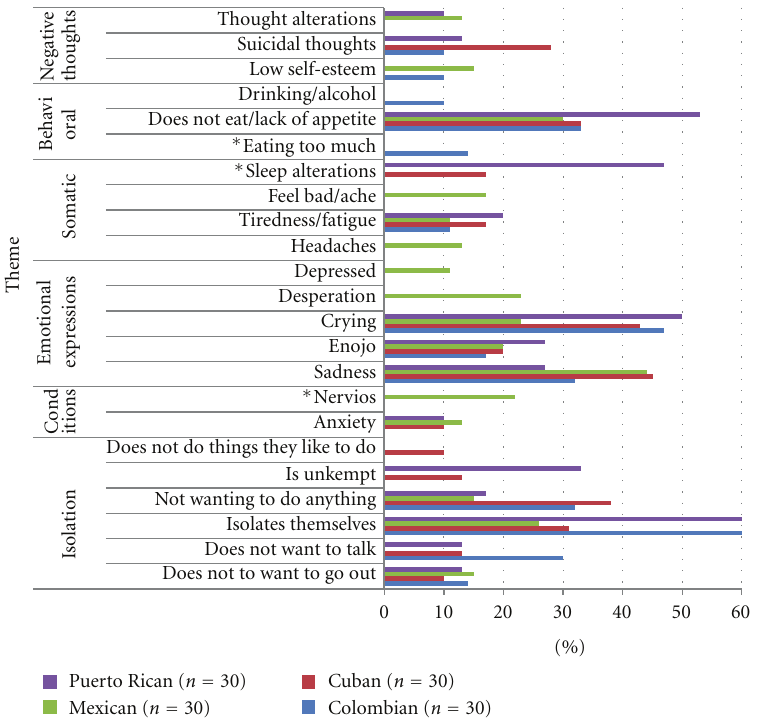
Figure 2: Most frequently listed symptoms of